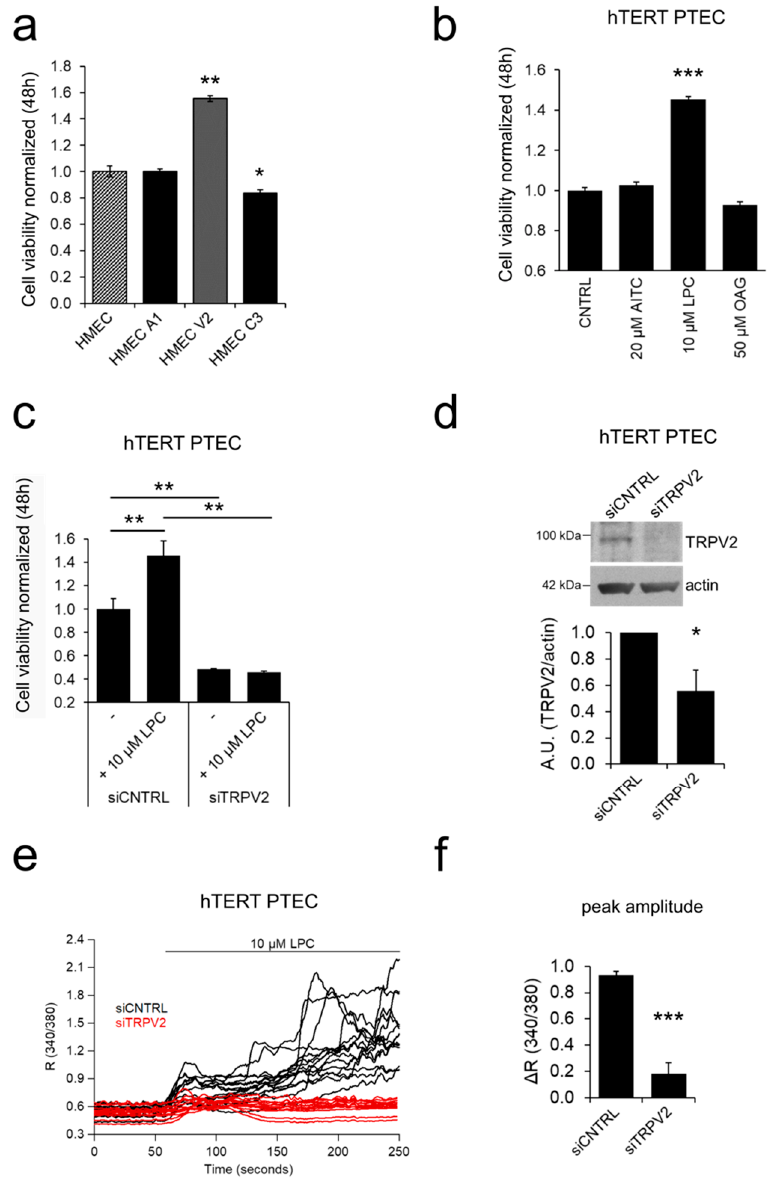
Figure 3. TRPV2 modulates EC viability. ( a ) The ‘ prostate-associated ’ channels were overexpressed in HMEC to test their effect on cell viability. Of all channels, only TRPV2-overexpression positively modulated proliferation in HMEC, 48 hours after transfection. Statistical significance *: p -value < 0.05 and **: p -value < 0.005 vs HMEC. ( b ) Treatment with the ‘ prostate-associated ’ channel agonists shows that 10 µM LPC induces an increase in hTERT PTEC viability 48 h after treatment. Agonists were added to the basal growth medium. Data represent the mean ± SEM of a minimum of three independent experiments. Statistical significance ***: p -value < 0.005 vs. control basal medium. ( c ) Silencing of TRPV2 expression significantly reduced hTERT PTEC viability, under both basal conditions and LPC stimulation and reverted the LPC-induced increase in PTEC viability observed in control cells. Statistical significance **: p -value < 0.005. ( d ) TRPV2 downregulation 48 h after siRNA transfection was verified by western blotting in hTERT PTECs. Histogram showing the quantification of TRPV2 expression relative to actin represented as the mean ± SEM of a minimum of three independent experiments. ( e ) Downregulation of TRPV2 expression was also studied in Ca 2+ imaging experiments 48 h after siRNA transfection by stimulation with 10 µM LPC in control and TRPV2-silenced hTERT PTEC. Each trace represents the ratio (340/380 nm) of a single cell in the field in one representative experiment.